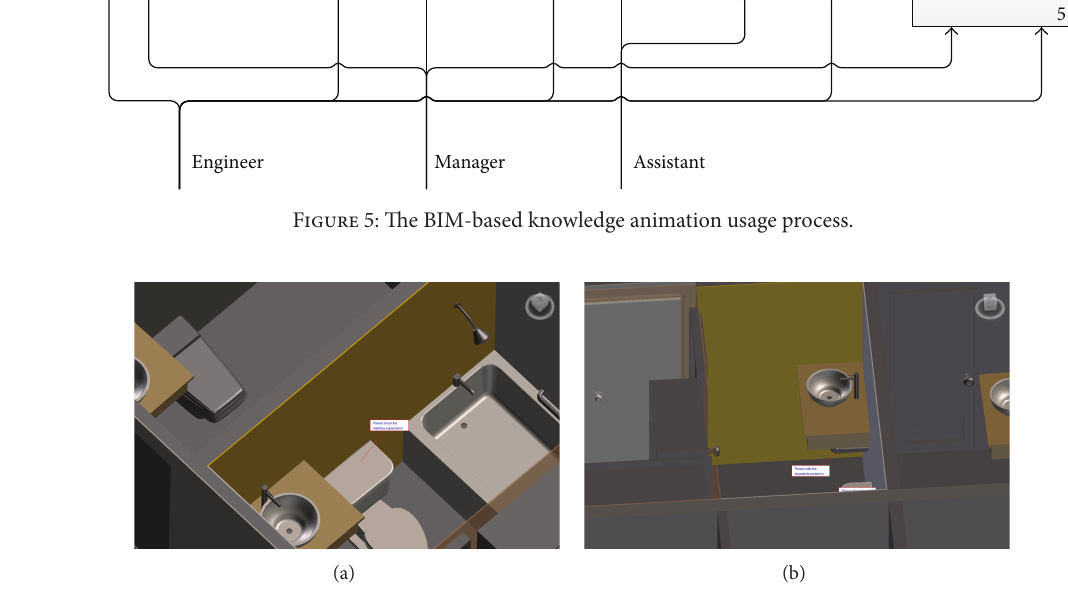
Figure 6: Application of BIM-based knowledge models for knowledge sharing in the case study.